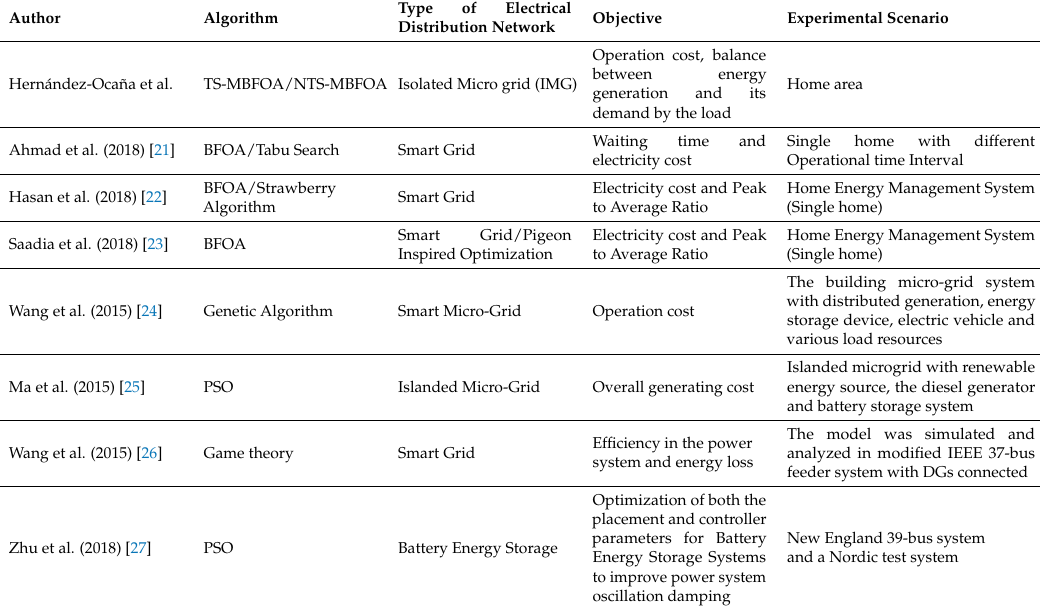
Table 1. Algorithms used for smartgrid